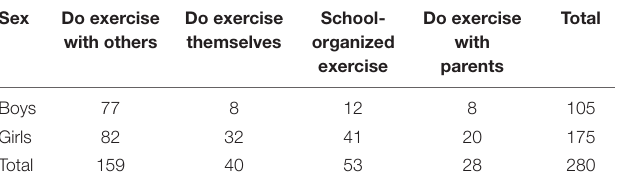
TABLE 4 | A survey of physical exercises of primary and middle school students in Tianjin.